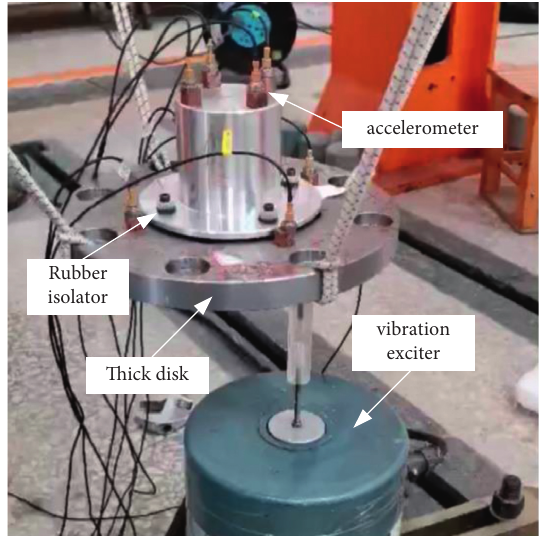
Figure 17: Experimental setup of the jointed structure.